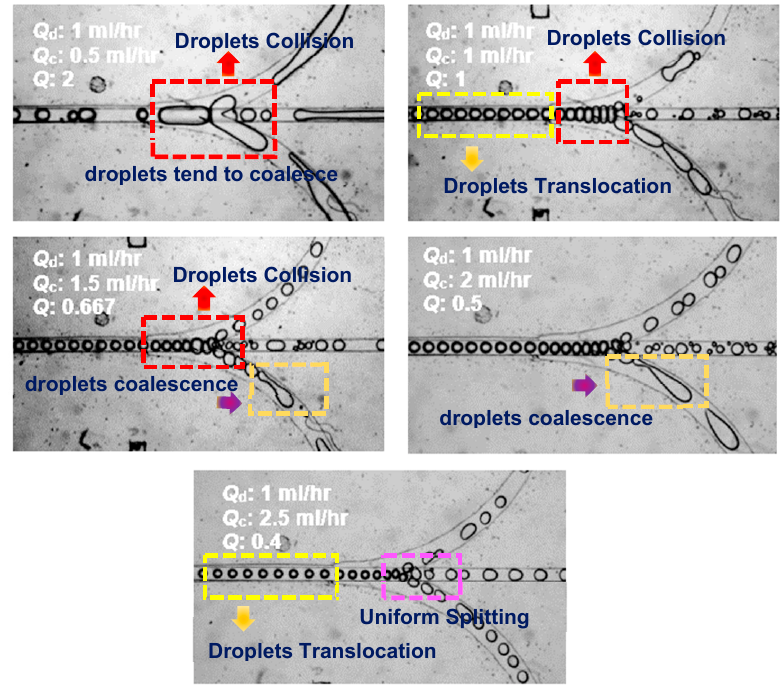
Figure 10. Droplet collision and coalescence phenomena in symmetrical splitting junctions at different flow rate ratio (0.4 < Q < 2) by fixing the Q d and varying the Q c .